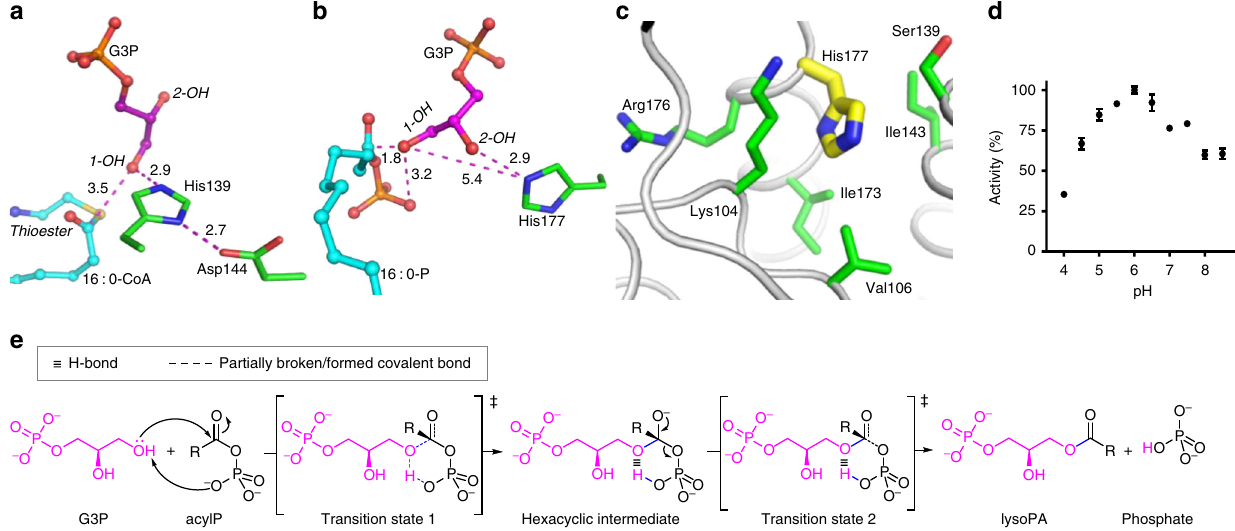
Fig. 6 The catalytic mechanism of PlsY. a The spatial arrangement between the ‘ Asp-His ’ dyad and the docked substrates of the squash – spinach chimeric GPAT 34 . The critical His139 is close to the G3P 1-OH, suitable for deprotonation. b The spatial arrangement between His177 and the two substrates from aa PlsY aa PlsY 16:0-P and G3P . His177 is 5.4 Å apart with the G3P 1-OH, unsuitable for deprotonation. Dashed lines in a and b indicate distances (Å). c